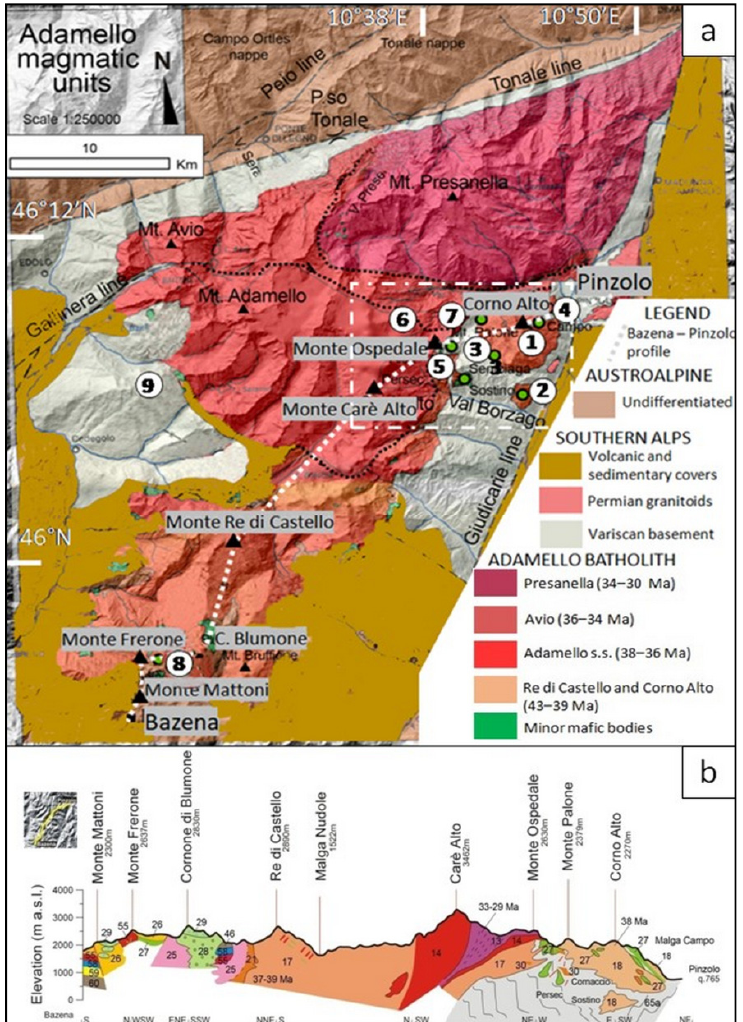
Figure 2. ( a ) Samples locations in the Adamello batholith and trace of the geological section.Numbers as follows: (1) Corno Alto, (2) M.ga Sostino, (3) M. Palone, (4) M.ga Campo, (5) M. Persec, (6) M.